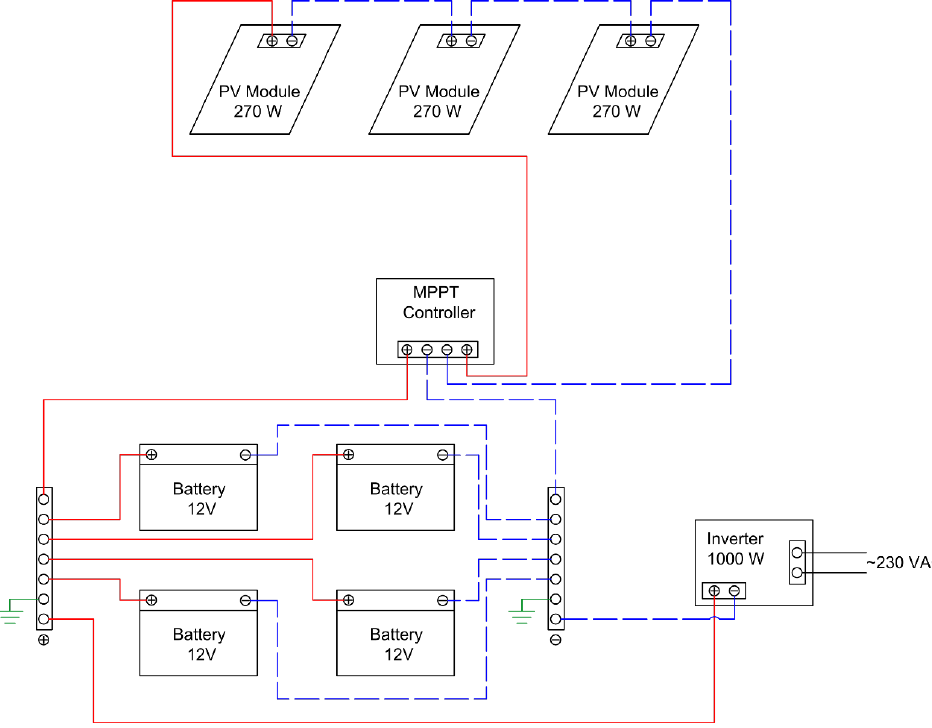
Figure 5. Electrical circuits scheme (Source: Own elaboration) .